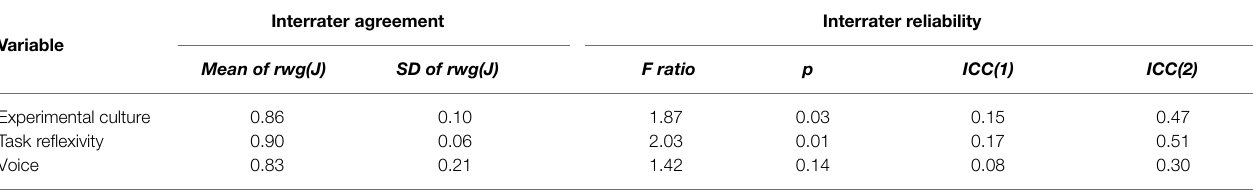
TABLE 3 | Indices for interrater agreement and interrater